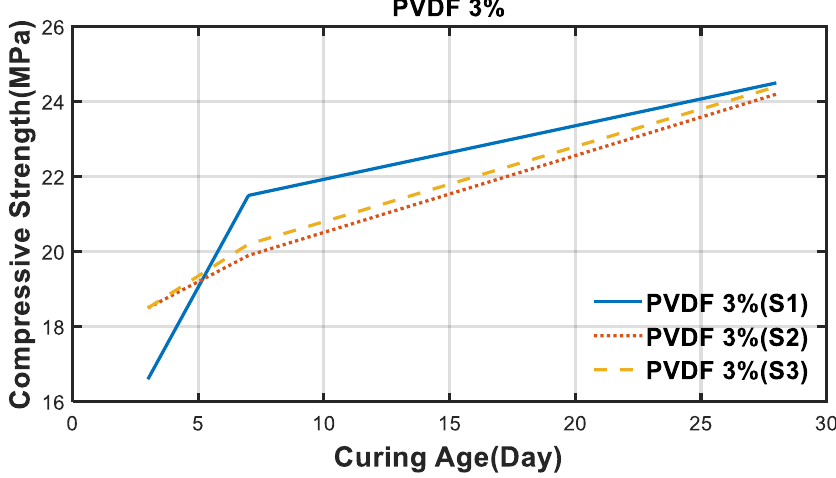
Figure 10. Graph of strength measurement results between PVDF (3%) specimens.